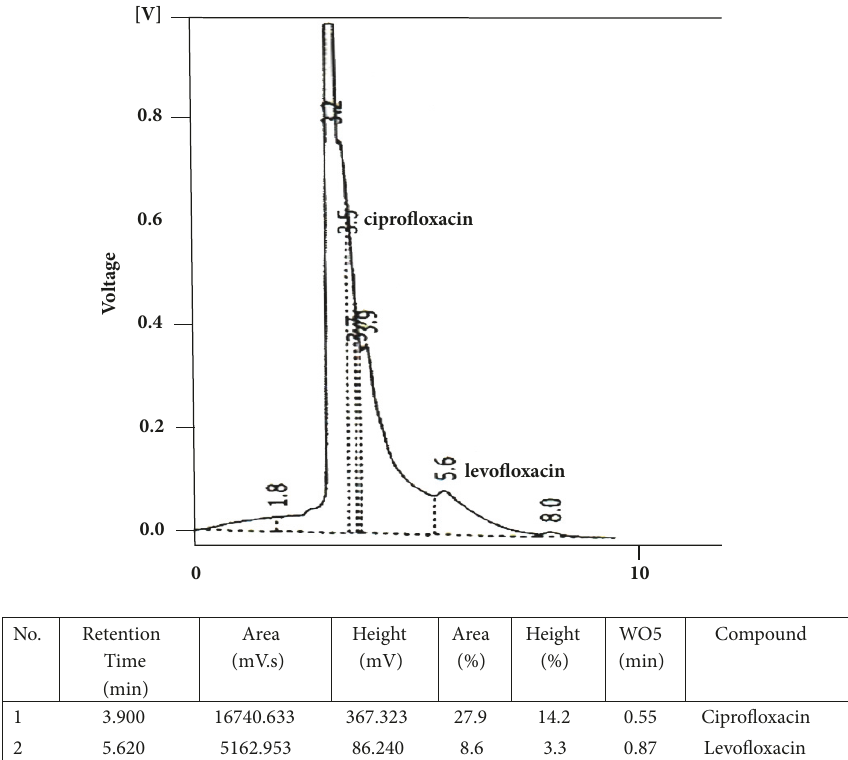
Figure 5: HPLC-RF analysis of target antibiotics ciprofloxacin and levofloxacin at the Al-Rasheed plant. Ciprofloxacin is represented by the first peak (3.9) and levofloxacin by the second peak (5.6) during 10min of the procedure.